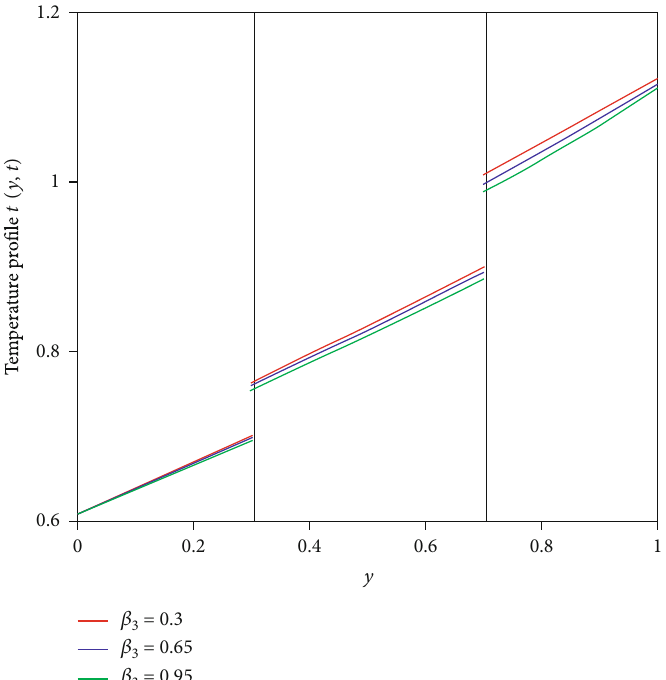
ð y , t Þ , i = 1, 2, 3 versus y for fractional multilayer Maxwell fl uid at t = 0 : 002, β i